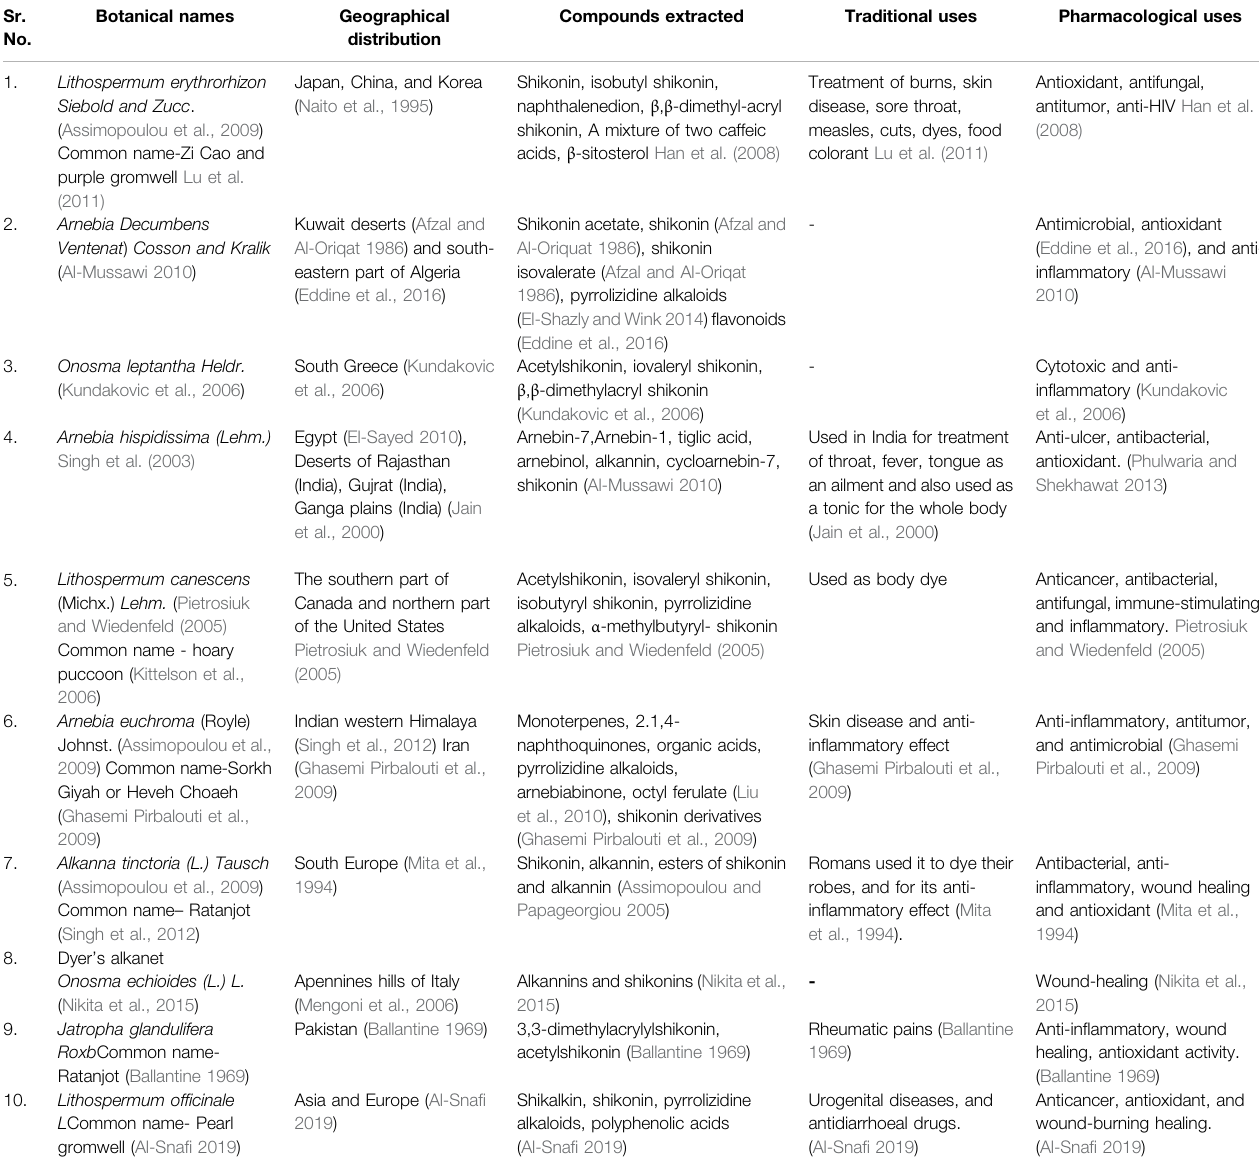
TABLE 1 | Natural sources of shikonin and its derivatives. Sr.